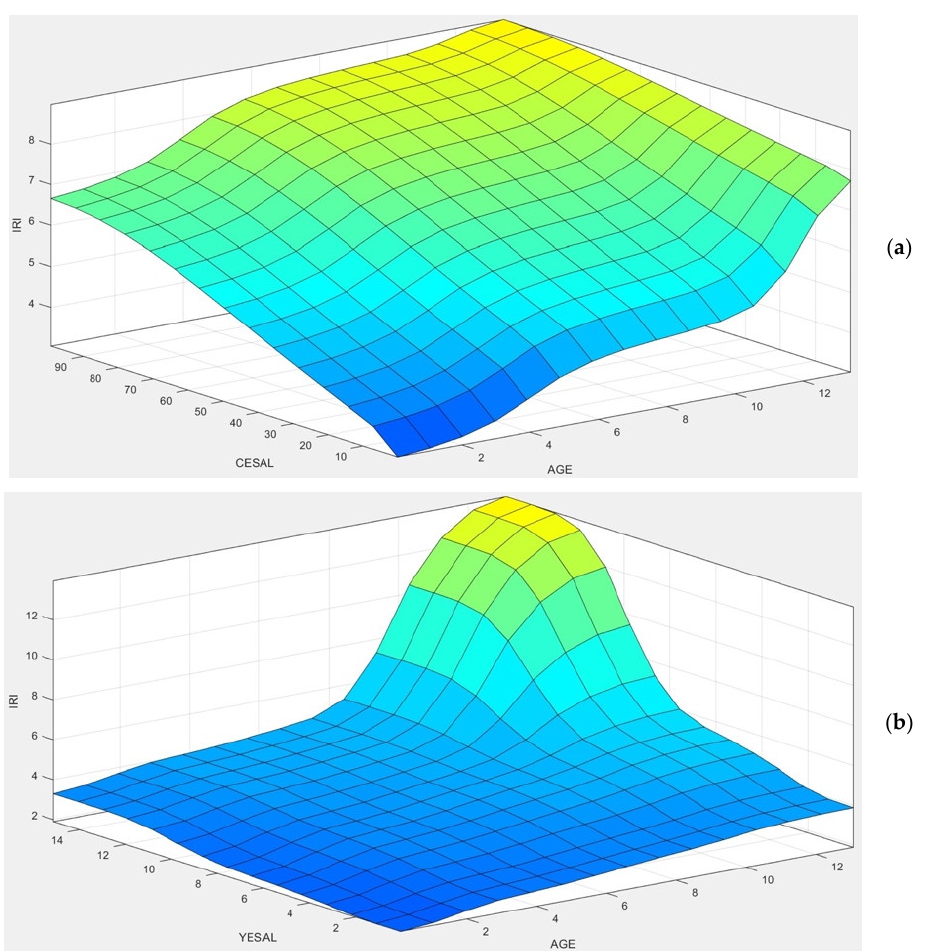
Figure 17. 3D surface plots for the effect of AGE and CESAL/YESAL on IRI for the ( a ) DBST model and ( b ) AC model.